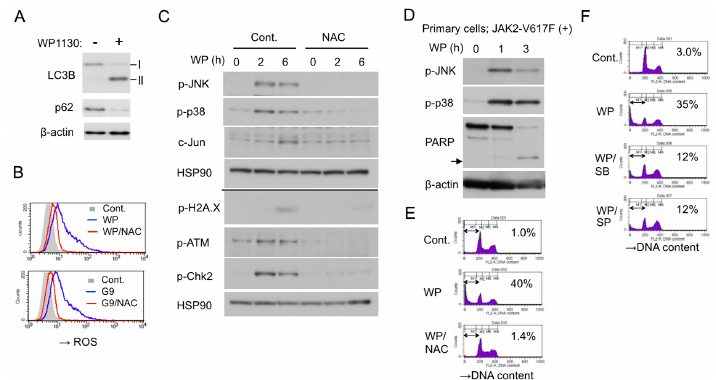
Figure 5. WP1130 causes oxidative stress to activate stress-related p38 / JNK MAPKs pathways and DNA damage responses to induce apoptosis. ( A ) HEL cells were treated for 6 h with or without 5 μ M